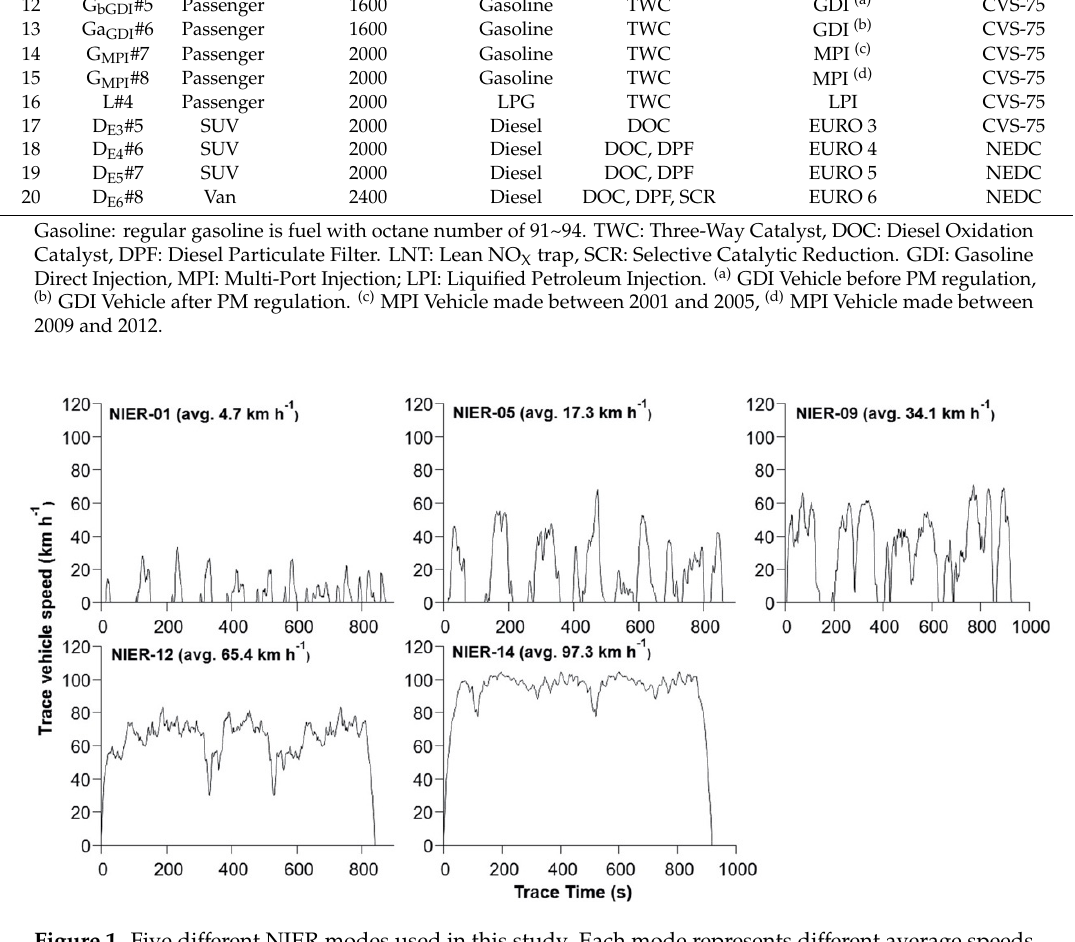
Figure 2. Regulation modes used in measurement. CVS-75 mode used in gasoline, LPG, and diesel vehicles for EURO 3. NEDC mode used in diesel vehicles after EURO 4. 2.2. Measurement Method and Calculation Formula for Emission Estimation A schematic of the BC emission measurement method is shown in Figure 3. BC concentrations was continuously measured at 1min interval using an Aethalometer (AE33, Magee Scientific) which incorporated the patented Dual-Spot technology and a seven wavelength (370, 470, 520, 590, 660, 880, 950 nm) [17]. The flow rate of emissions into the equipment was set at 2 LPM and had been tested during the cycles, the deviation of the flow rate was found within 5%. Simultaneously, the leakage test of the filter was performed and was also under <10% the appropriate range provided by the manufacturer. To determine the BC concentrations, the mass absorption cross-section (MAC) 7.77 m 2 g − 1 at 880 nm was used [17]. Two sampling systems were conducted for measuring BC. The constant volume sampler (CVS) tunnel system first diluted the raw exhaust from vehicles using the CVS tunnel, and then, moisture was controlled from the diluted emission using a diffusion dryer; finally, particles with a maximum size of 2.5 μ m were captured using a URG cyclone. Tail-pipe system used direct sucking from the exhaust of the vehicles, and the subsequent measurement method was the same as that of the CVS tunnel system. The PM weight was measured using the PM sampler in all driving modes from the CVS tunnel. However, the PM concentration in the NIER modes, which